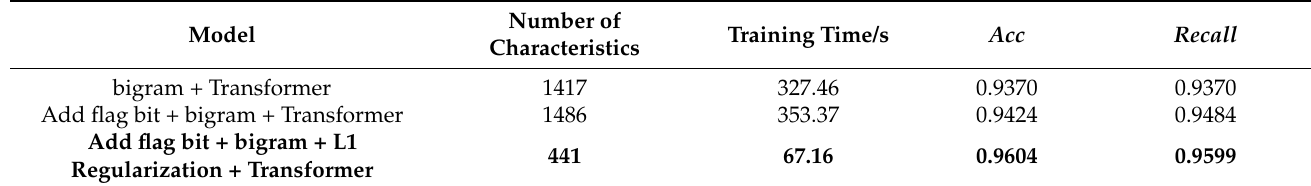
Table 6. Experimental analysis of single detection model.